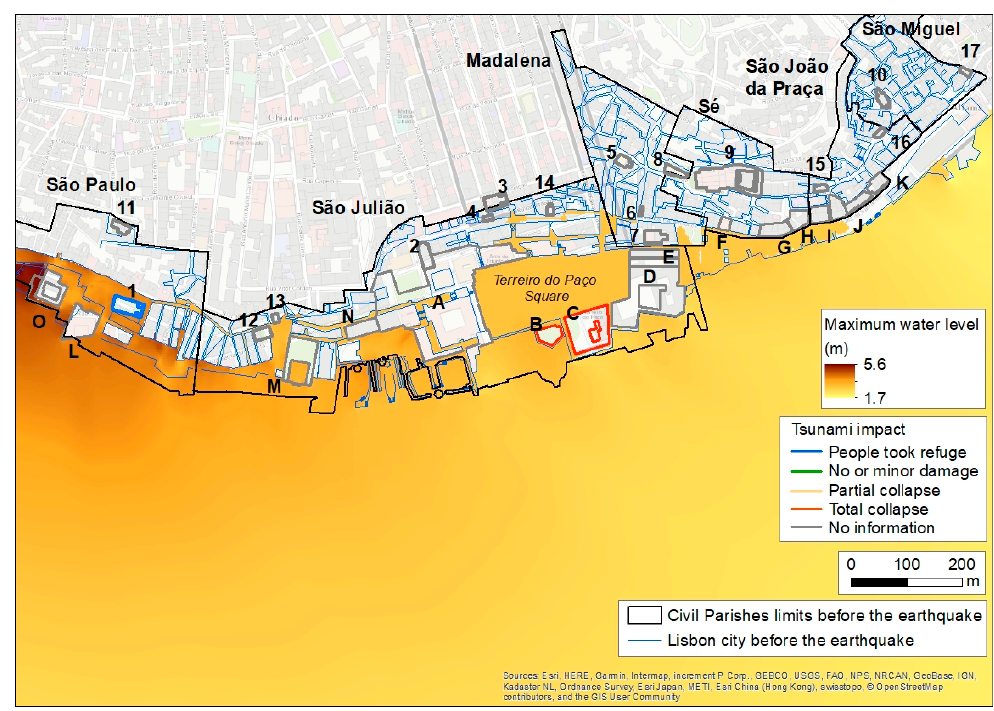
Figure 17. Numerical model results: maximum water level. The list of churches and buildings is listed in the caption of Figure 10.